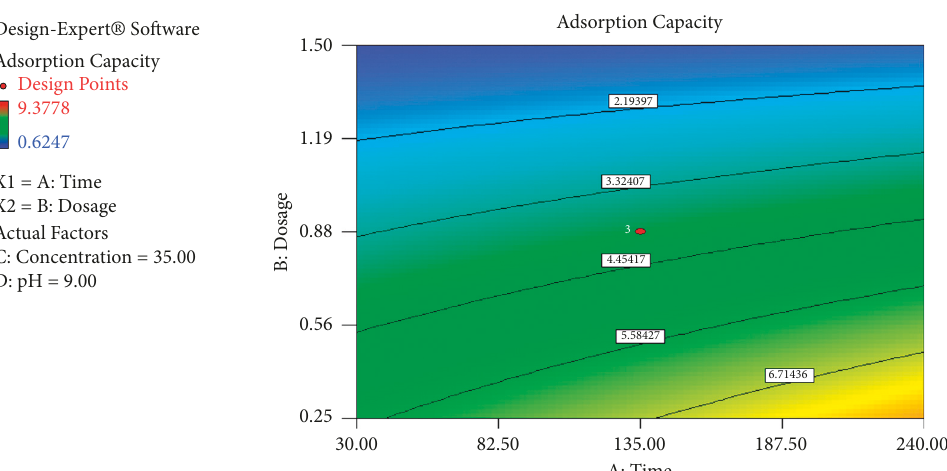
Figure 1: Contour plot for the interaction between time and dosage on adsorption capacity of MB dye.